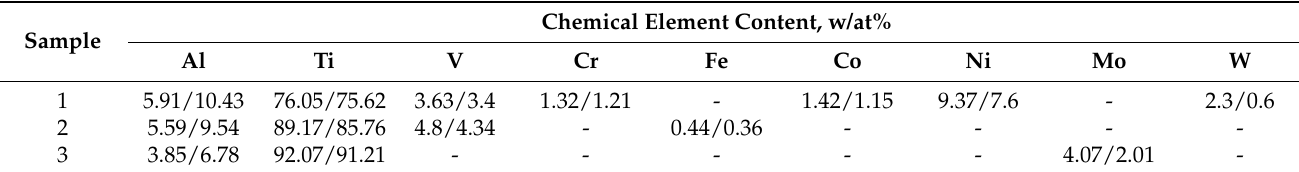
Table 8. Results of the chemical composition analysis performed on the joint section.